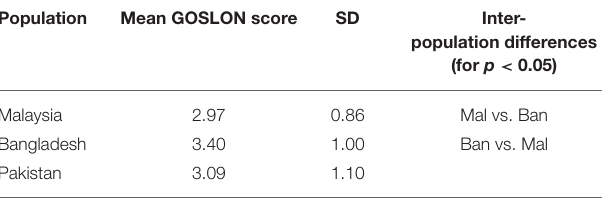
TABLE 2 | Comparison of mean GOSLON scores between the three